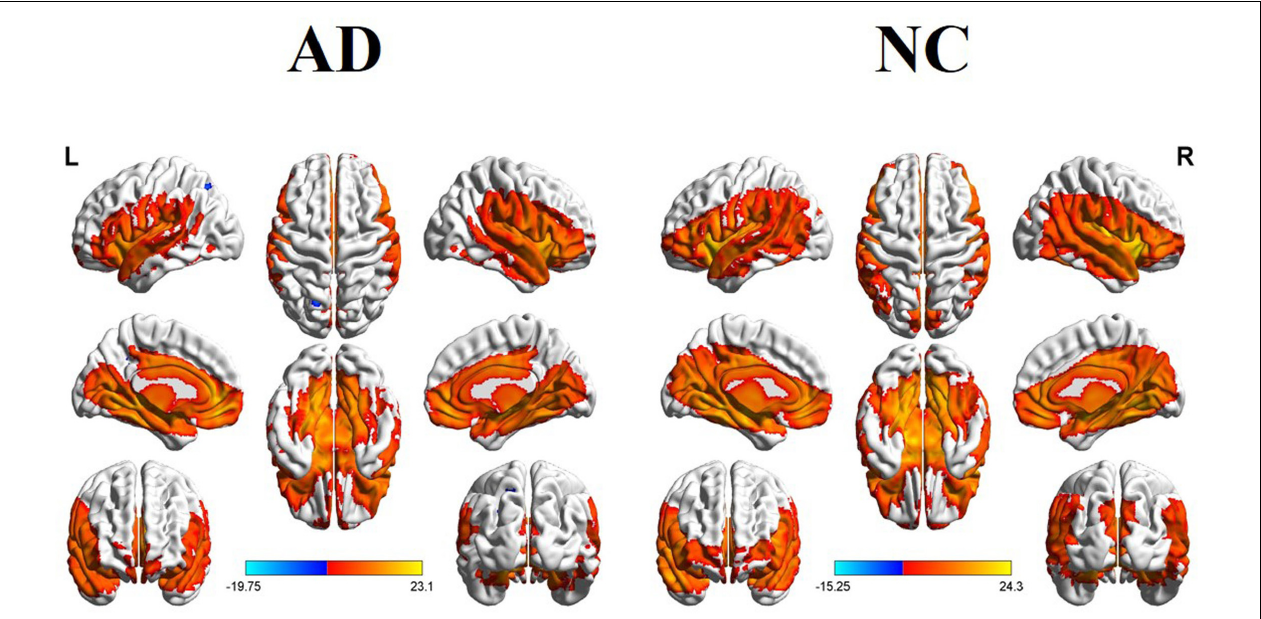
FIGURE 1 | Whole brain rCBF maps in the AD and NC groups (with FEW-corrected P <